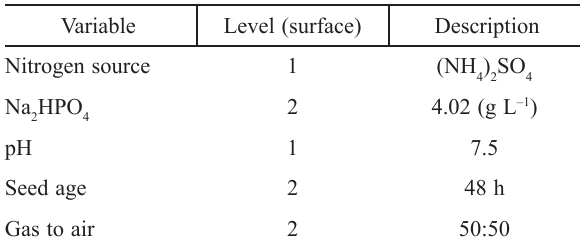
Table 5 – Optimum conditions for PHB production in bubble column bioreactor by the isolated